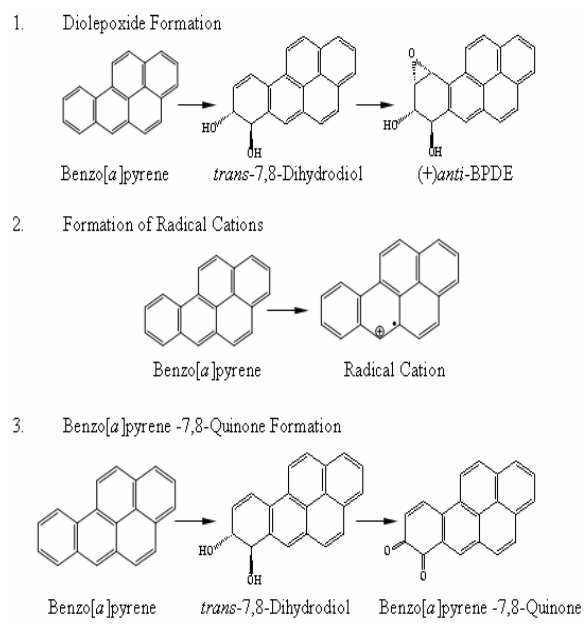
Figure 1: The three principal metabolic activation pathways of benzo[ a ]pyrene leading to tumour initiation. Skin is the largest body organ in humans and a principal target organ on cancer induced by PAHs. Phototoxicity of PAHs has been recognized more than seventy years ago [17- 22]. It has also been reported that upon light irradiation, PAHs exhibit phototoxicity [17]. Thus, photoirradiation of PAHs can be an activation pathway and may play an important role on skin cancer [23-26]. However, this pathway has received much less attention. In the